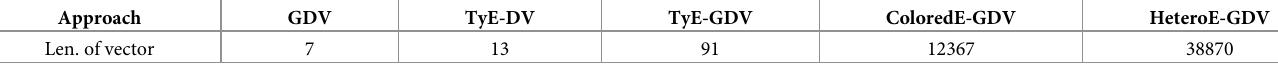
Table 4. Comparison of vector length of different approaches.